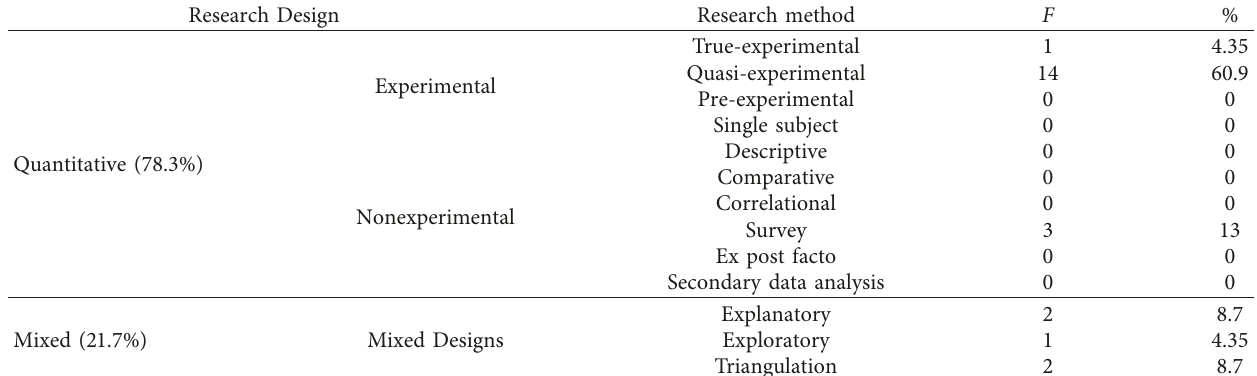
Quantitative (78.3%)